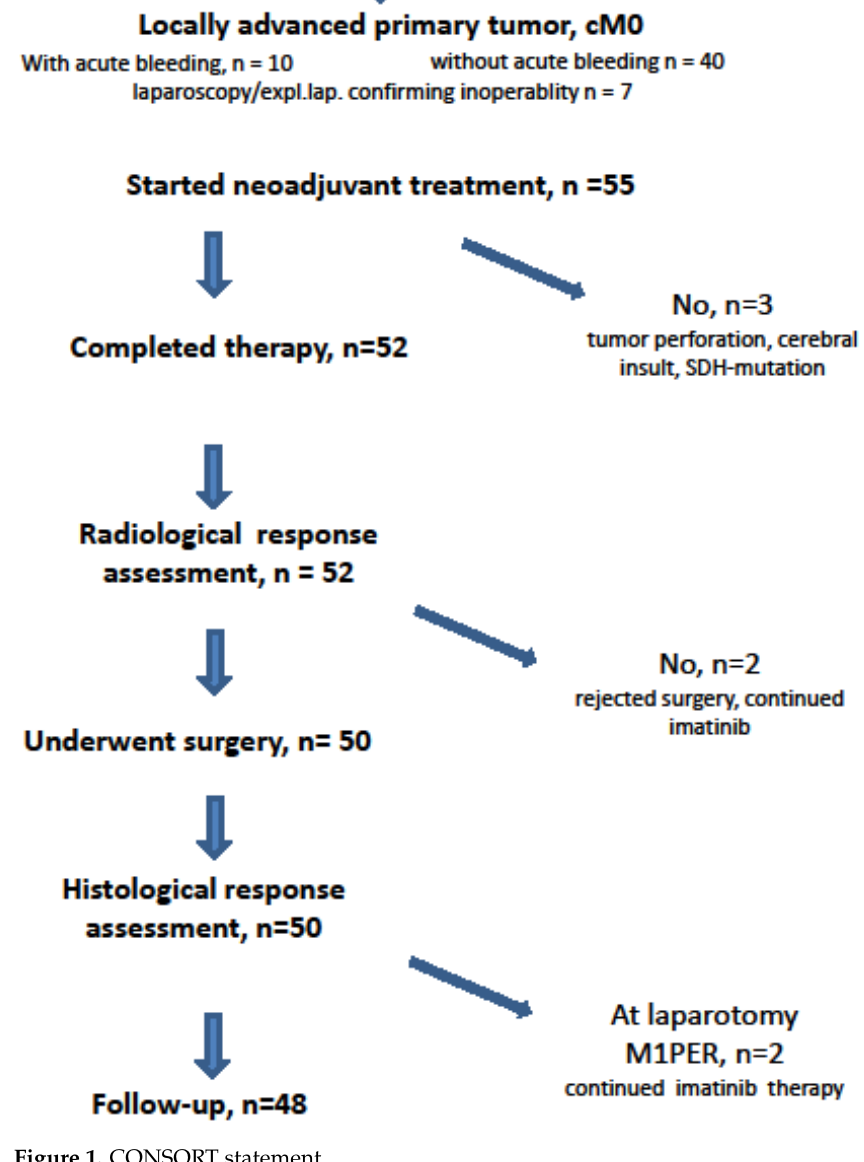
Figure 1. CONSORT statement.